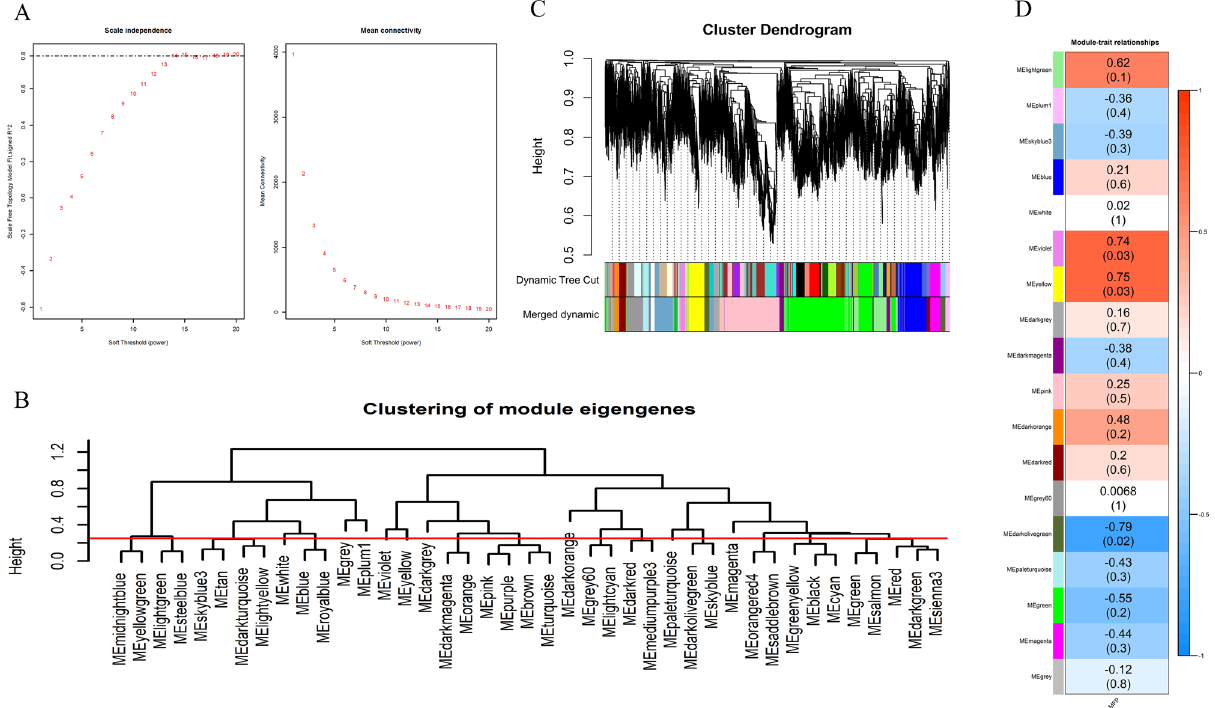
Figure 2. Weighted gene co-expression network analysis. ( A ) Analysis of the scale-free fit index for various soft-thresholding powers (left) and analysis of the mean connectivity for various soft-thresholding powers (right); ( B ) module clustering diagram, the height of the red line is 0.25, the modules below the line are the ones that are more similar and need to be merged; ( C ) gene dynamic shearing clustering tree, each color represents a module. The color in the first row is the result of the first clustering, and the color in the second row is the result of the modules after merging; ( D ) correlation analysis between module and MFP. Red represents positive correlation, green represents negative correlation, and the darker the color, the stronger the